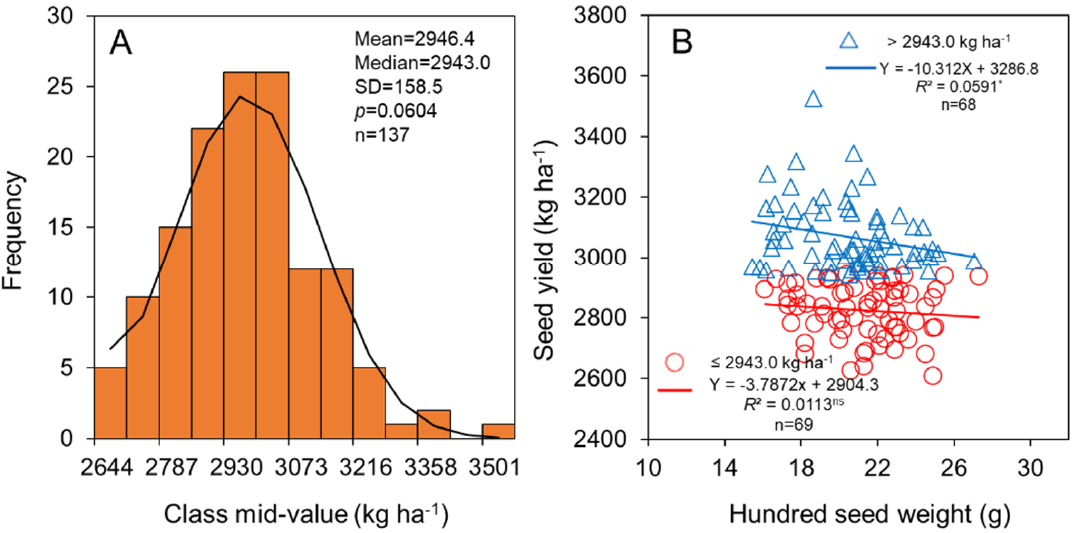
Figure 5. Relationship of seed yield ( A ) and hundred seed weight ( B ) for soybean. * indicates significance different at the 0.05 probability levels, while ns indicates not significant different.